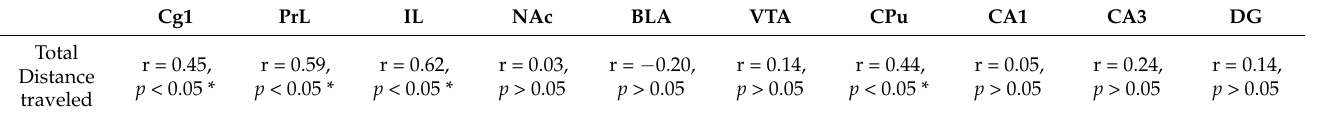
Table 1. Pearson correlation tests between total distance traveled (mm) and c-Fos expression in specific brain areas, including the Cg1, PrL, IL, NAc, BLA, VTA, CPu, CA1, CA3, and